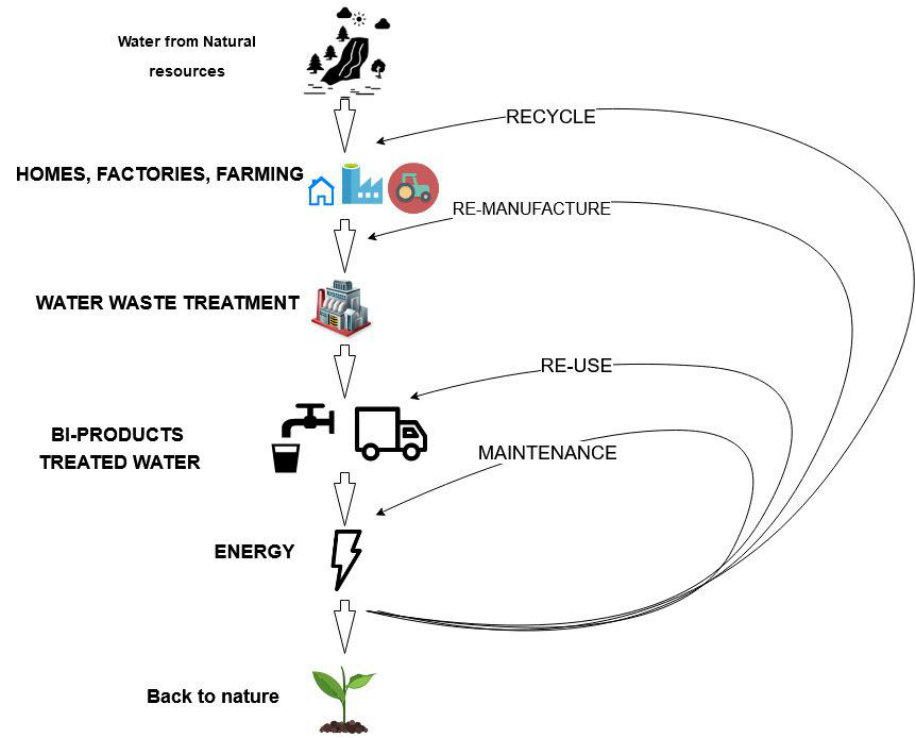
Figure 2. A redrawn example of a circular economy model.